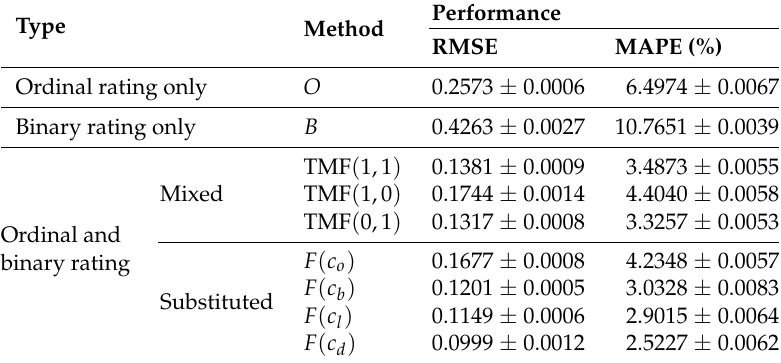
Figure 7. Heatmap representation of the feedback rating matrices, where x and y -axis respectively represent the users and editing experts belong to the test set. Table 3. Recommendation performances of the proposed method and compared methods with respect to the type of the utilized user feedback in terms of RMSE and